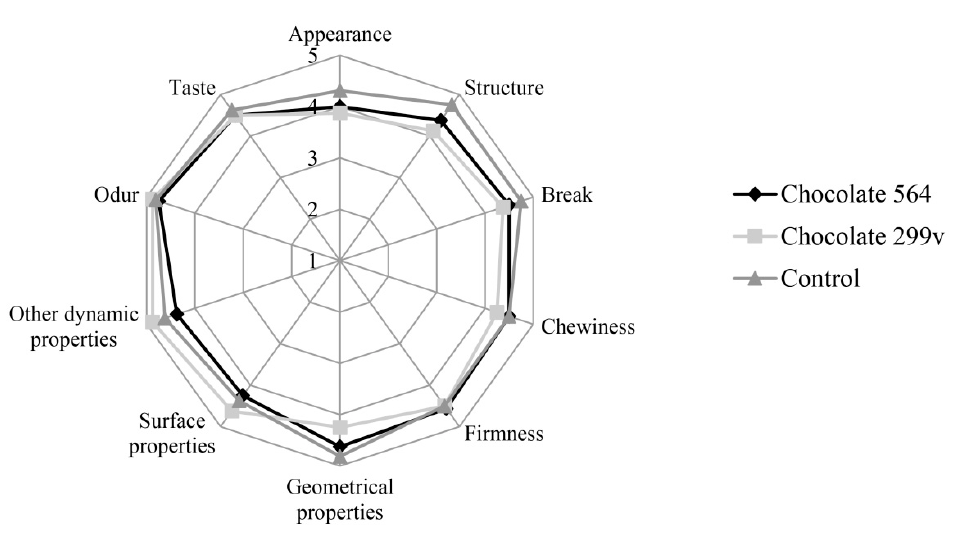
Figure 3. Sensory evaluation of dark chocolates with probiotic bacteria after 60 days of storage at 20 °C.